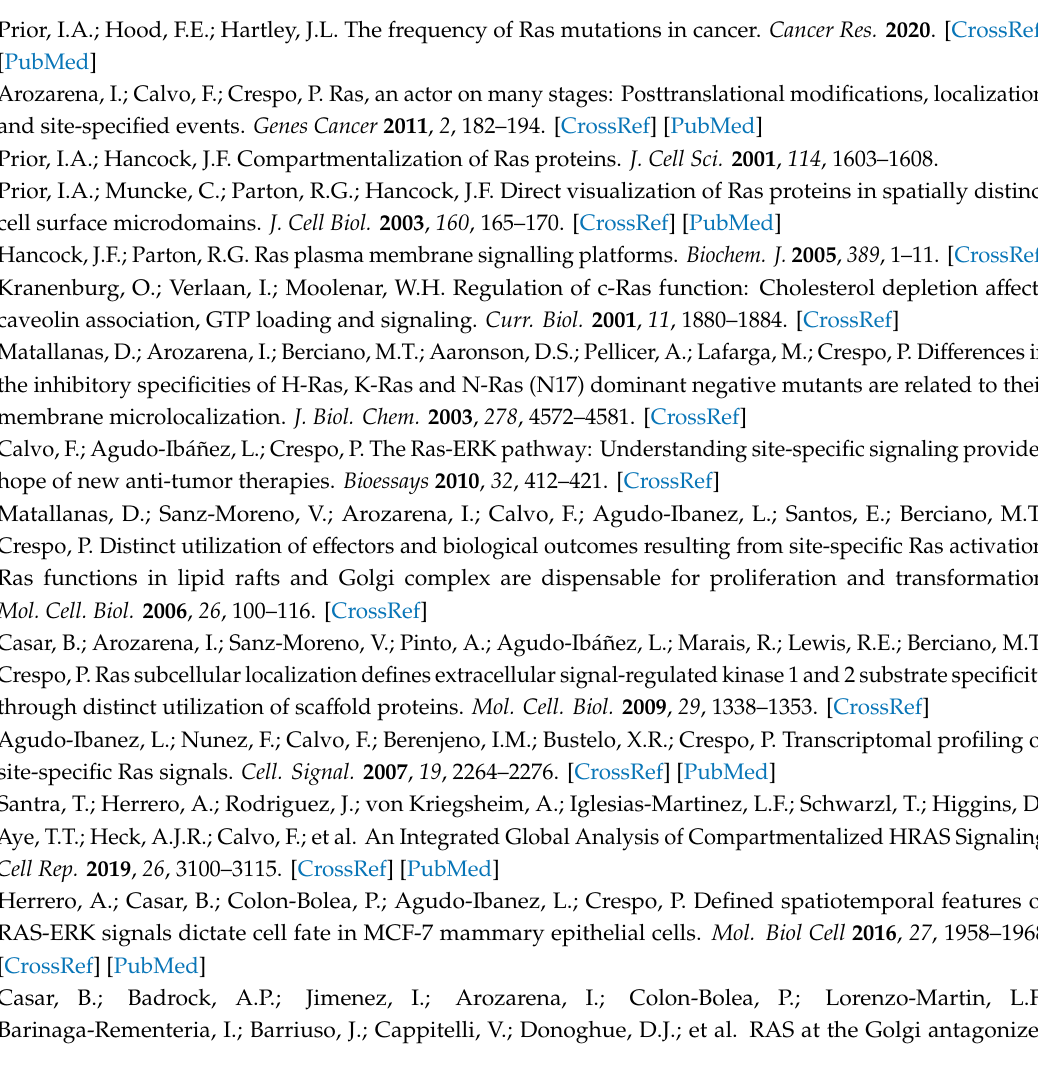
Figure S1: Tumor formation by PCCL3 cells expressing HRAS at the indicated sublocalizations, Figure S2: Genetic alterations in APT-1 (LYPLA1), HRAS, and NRAS in papillary thyroid carcinomas, Figure S3: Unprocessed images for Western Blot results corresponding to the Figure 1A. Figure S4: Unprocessed images for Western Blot results corresponding to the Figure 3A,B. Figure S5: Unprocessed images for Western Blot results corresponding to the Figure 4B,C. Figure S6: Unprocessed images for Western Blot results corresponding to the Figure 5D. Figure S7: Unprocessed images for Western Blot results corresponding to the Figure